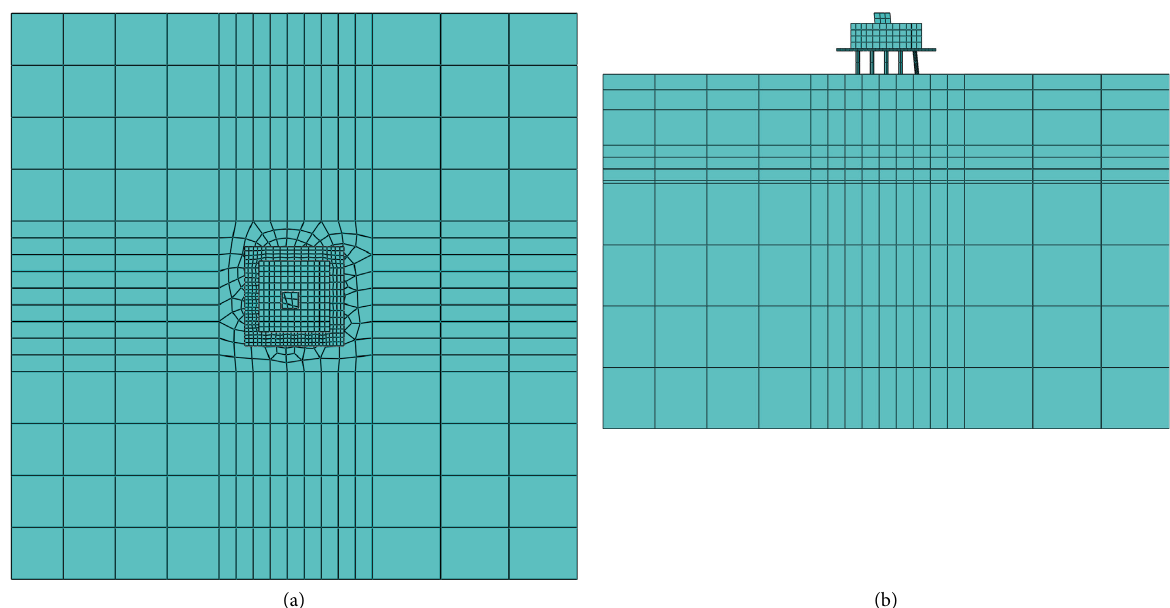
Figure 7: Single cap model: (a) vertical view of single cap model; (b) lateral view of single cap model.